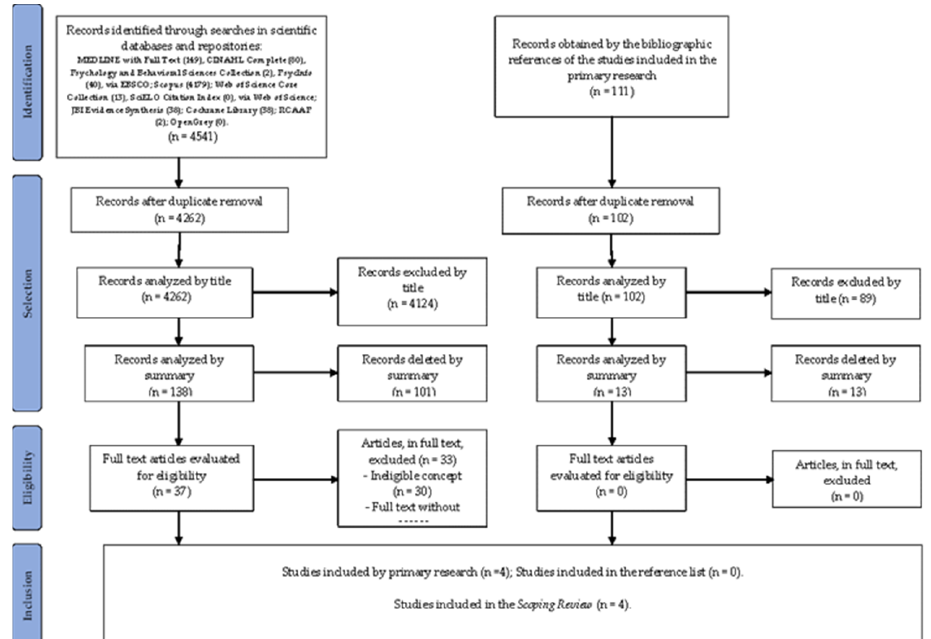
Figure 1. PRISMA- ScR flowchart (adapted) of the study selection process [21].